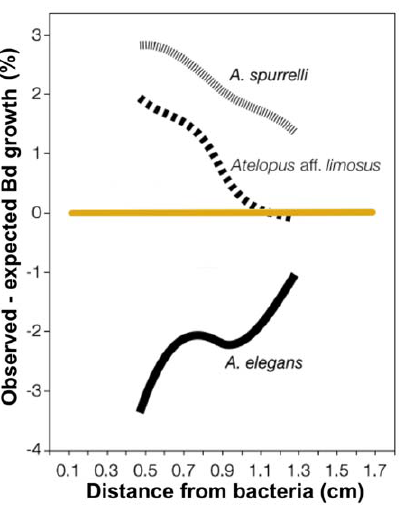
Figure 4. Residuals of Bd growth after the toad species from which the bacteria were recovered. Residual analysis of the aforementioned model to summarize differences between bacterial isolates grouped after the frog species from which they were recovered. Atelopus elegans is the only species we found infected with Bd in its natural